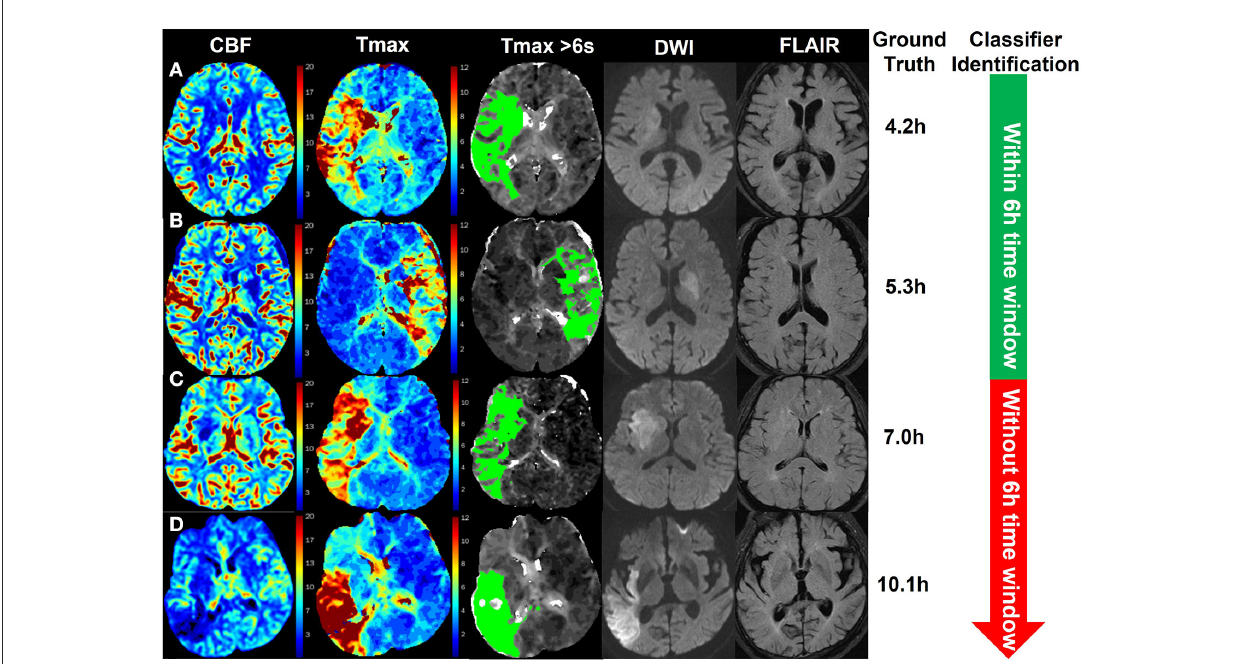
FIGURE5 Examples of the identification of patients with AIS within a 6-h window for the treatment of EVT using the CNN classifier trained by CBF, Tmax, and ROI masks of Tmax > 6s. The green region in the third column is the mask of Tmax > 6s. The stroke onset times of patients (A, B) were, respectively, 4.2 and 5.3h, which was identified within a 6-h time window for the treatment of EVT by the classifier. For patients (C, D) , their stroke onset time was 7.0 and 10.1h, respectively, which was identified without a 6-h window by the